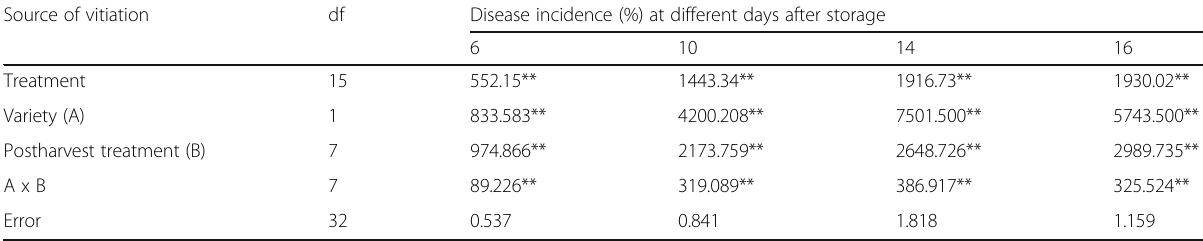
Table 10 Analysis of variance (mean square) of the data for disease incidence Source of vitiation df Disease incidence (%) at different days after storage